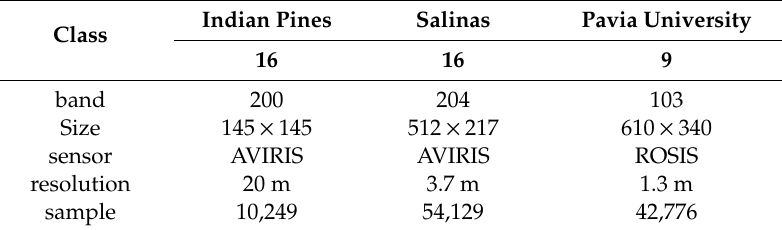
Table 1. The main features of three hyperspectral datasets.